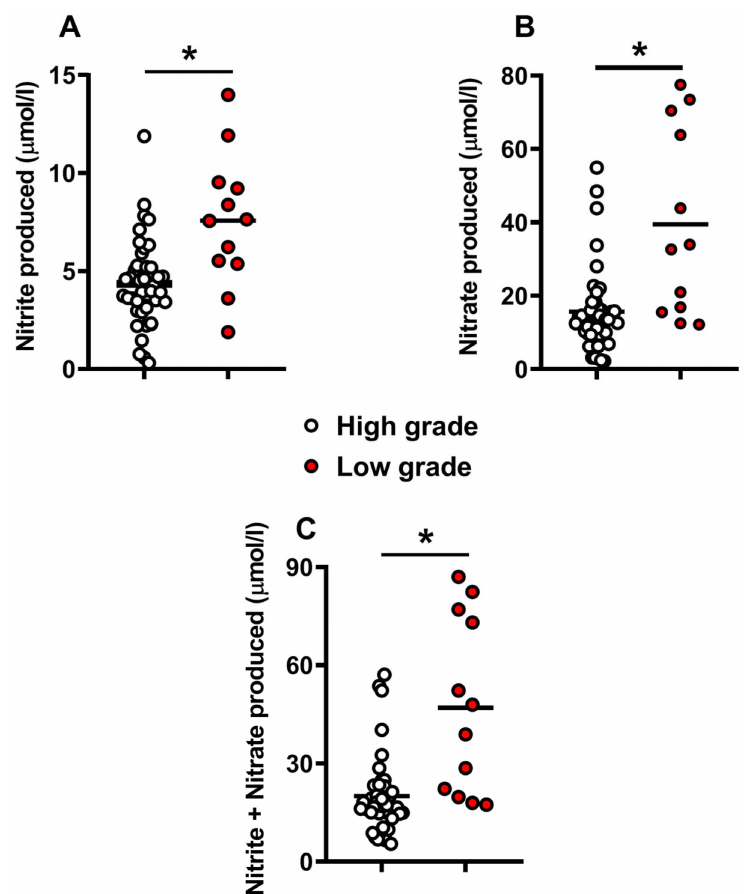
Figure 2. Concentrations of nitrite ( A ), nitrate ( B ), and nitrite + nitrate ( C ), as stable end-products of nitric oxide metabolism, detected in culture media of human embryos at 5 days post-fertilization. The two groups of high-grade (n = 54, empty circles) and low-grade (n = 12, red filled circles) embryos were morphologically classified according to the Gardner scale. The mean values are represented by the horizontal bars. * Significantly different from high grade, q < 0.001, ( A – C